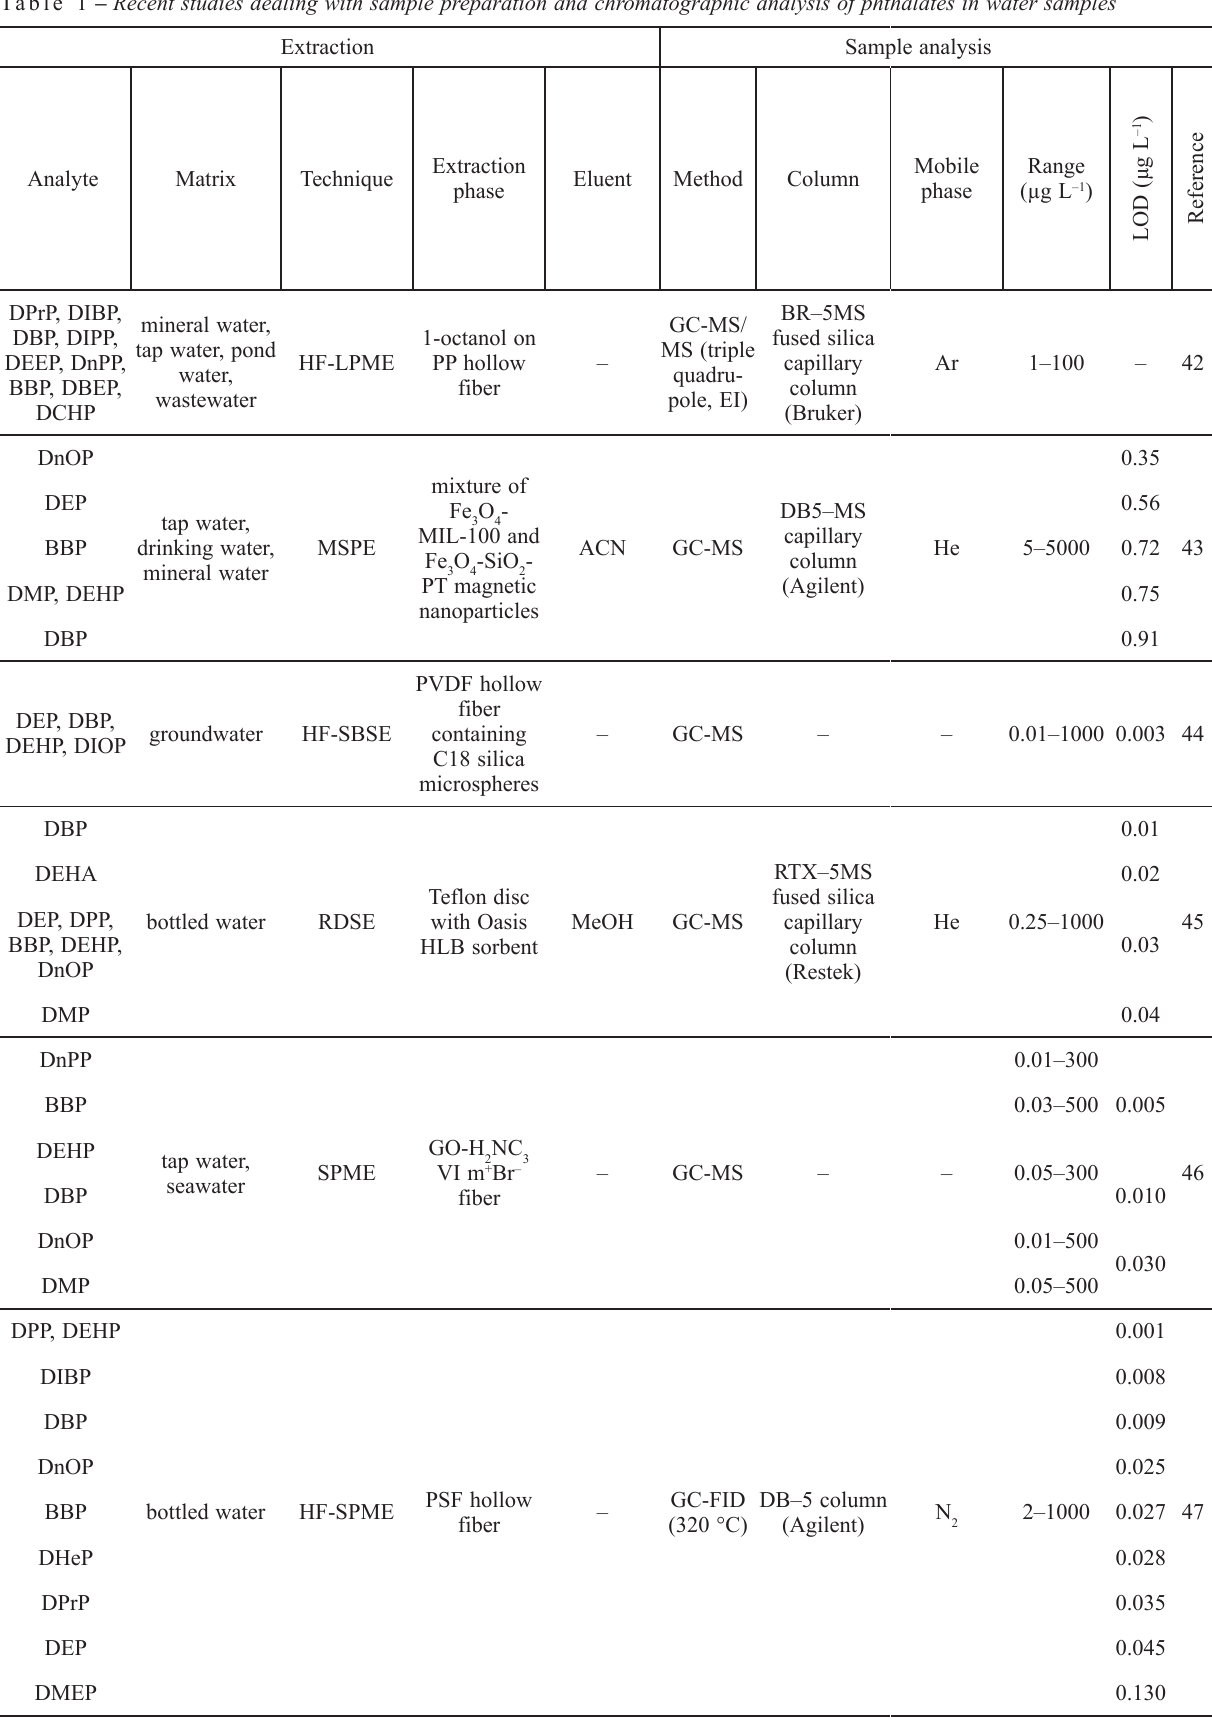
Table 1 – Recent studies dealing with sample preparation and chromatographic analysis of phthalates in water samples